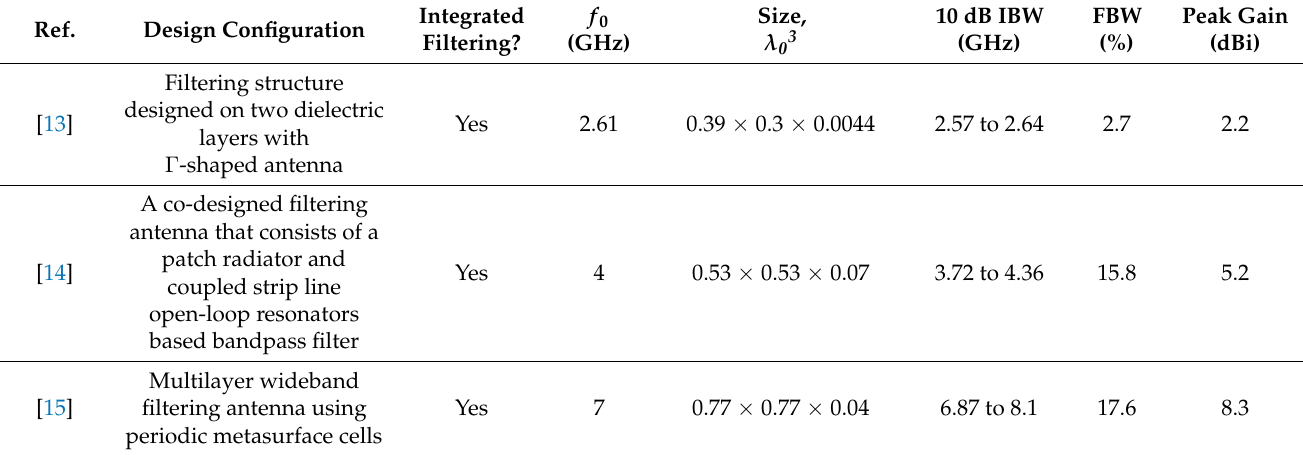
Table 5. Comparison of the proposed design with previous filtering antenna designs in literature. Ref.